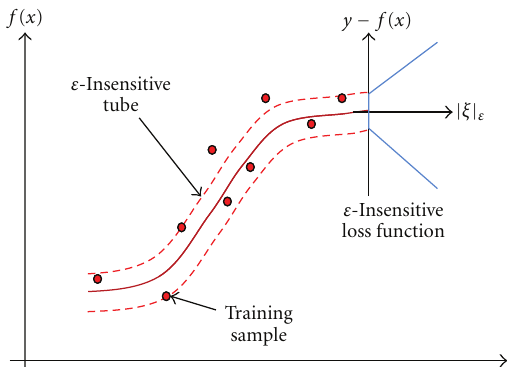
Figure 6: Example of a possible choice of the ε -insensitive loss function characterizing the SVR learning